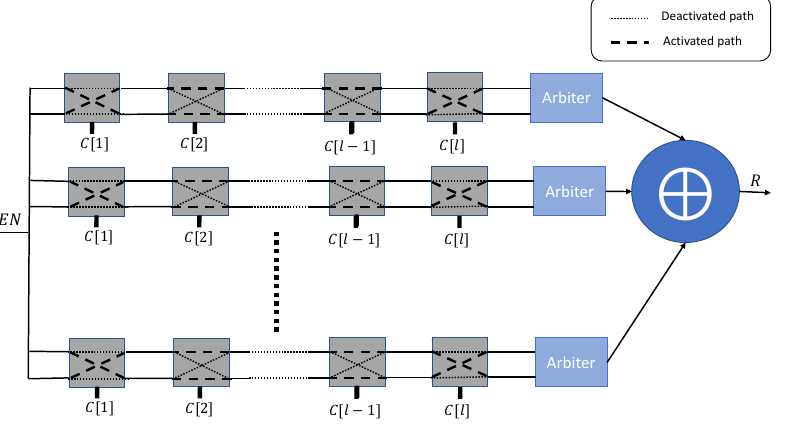
Figure 2. n -XOR Arbiter PUF architecture.